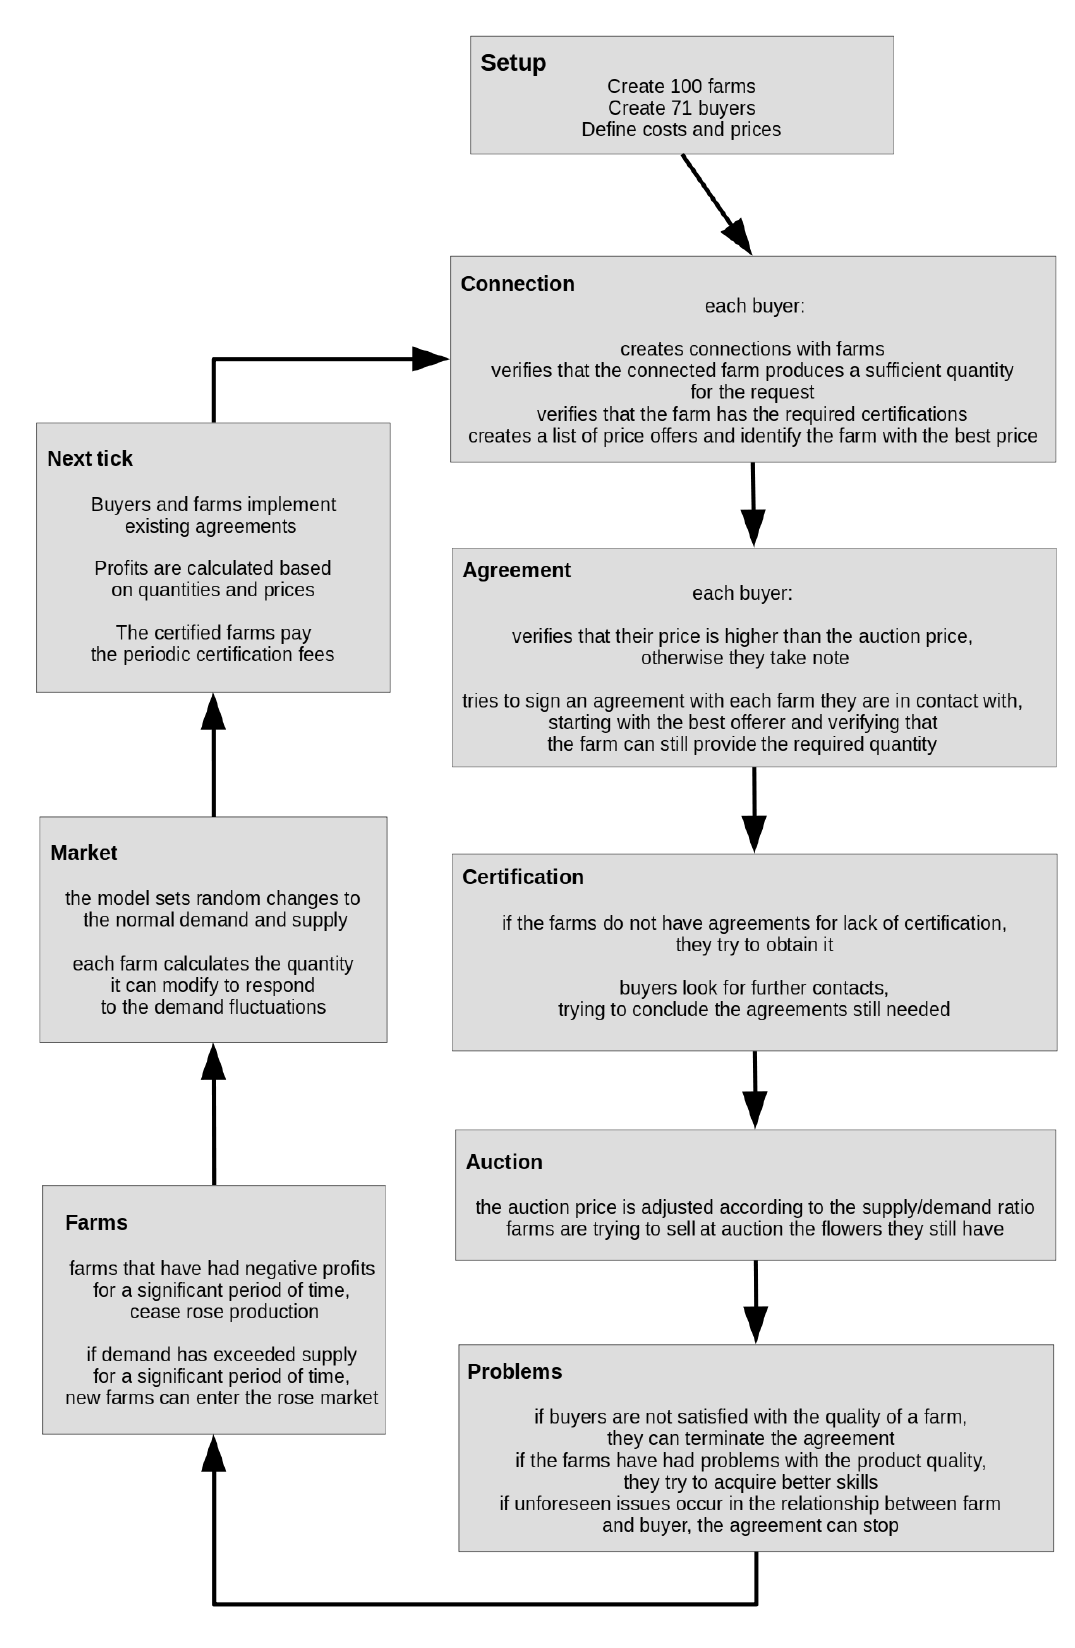
Figure 1. Model operating scheme.